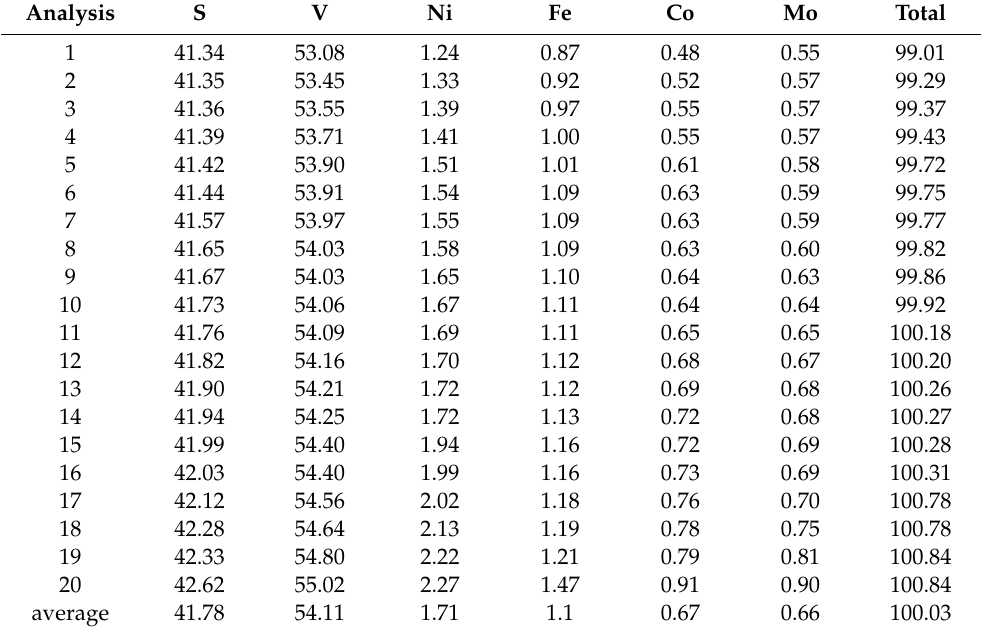
Table 1. Electron microprobe analyses (wt.%) of